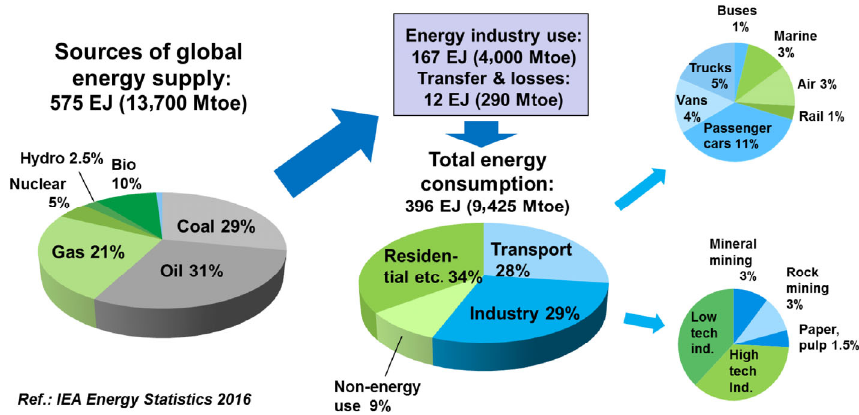
Fig. 3 Global energy supply and consumption in main economic sectors 2014. Mtoe = million tonnes of oil